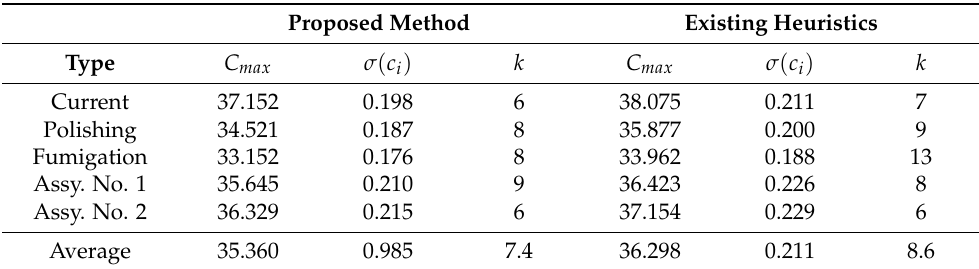
Table 3. Result of the experiment for the restructure of MMS perspective (unit: hour).